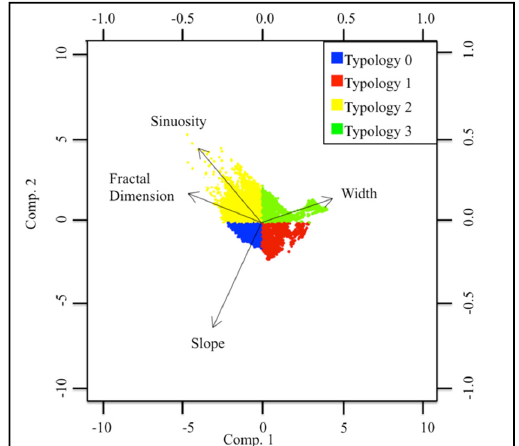
Figure 4. Biplot of PCA scores (colour coded by typology) and the four variable vectors: sinuosity, slope, fractal dimension, and stream width, plotted in relation to principal components 1 ( x -axis, 49% variation) and 2 ( y -axis, 24% variance).